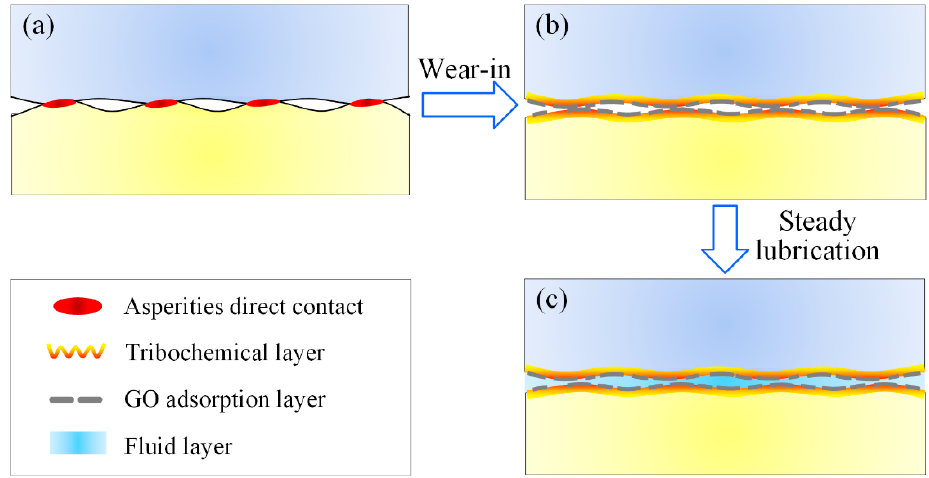
Figure 9. Lubrication model for GO and LiPF 6 containing DA(aq) solution at macroscale, ( a ) contact between asperities; ( b ) GO adsorption layer and tribochemical layer formed during wear − in stage; ( c ) GO adsorption layer, tribochemical layer, and fluid layer contributed to friction reduction during steady lubrication stage.